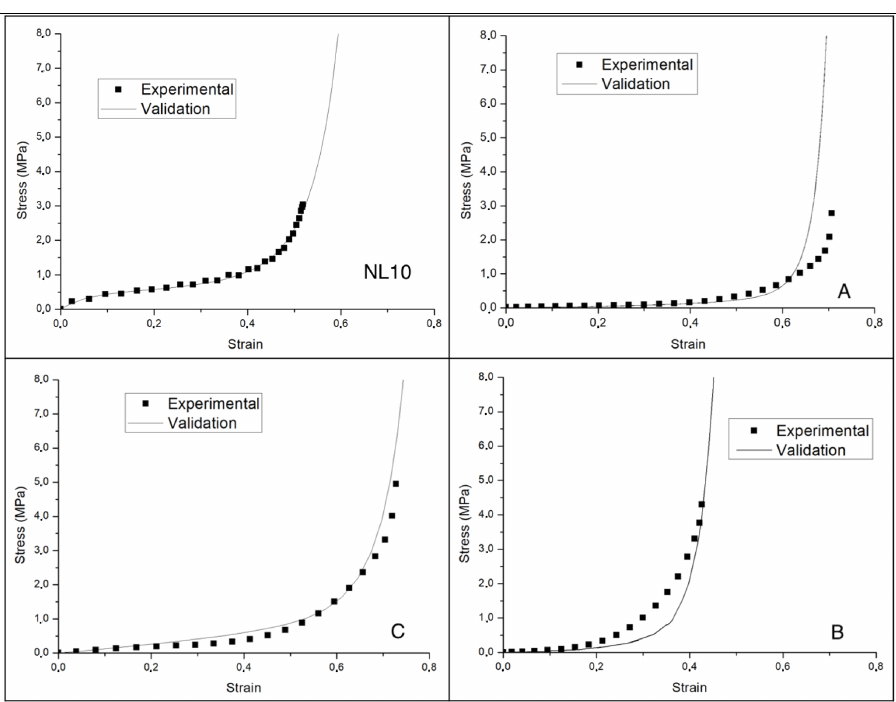
Figure 6. Dynamic test numerical validation for all the materials under study.